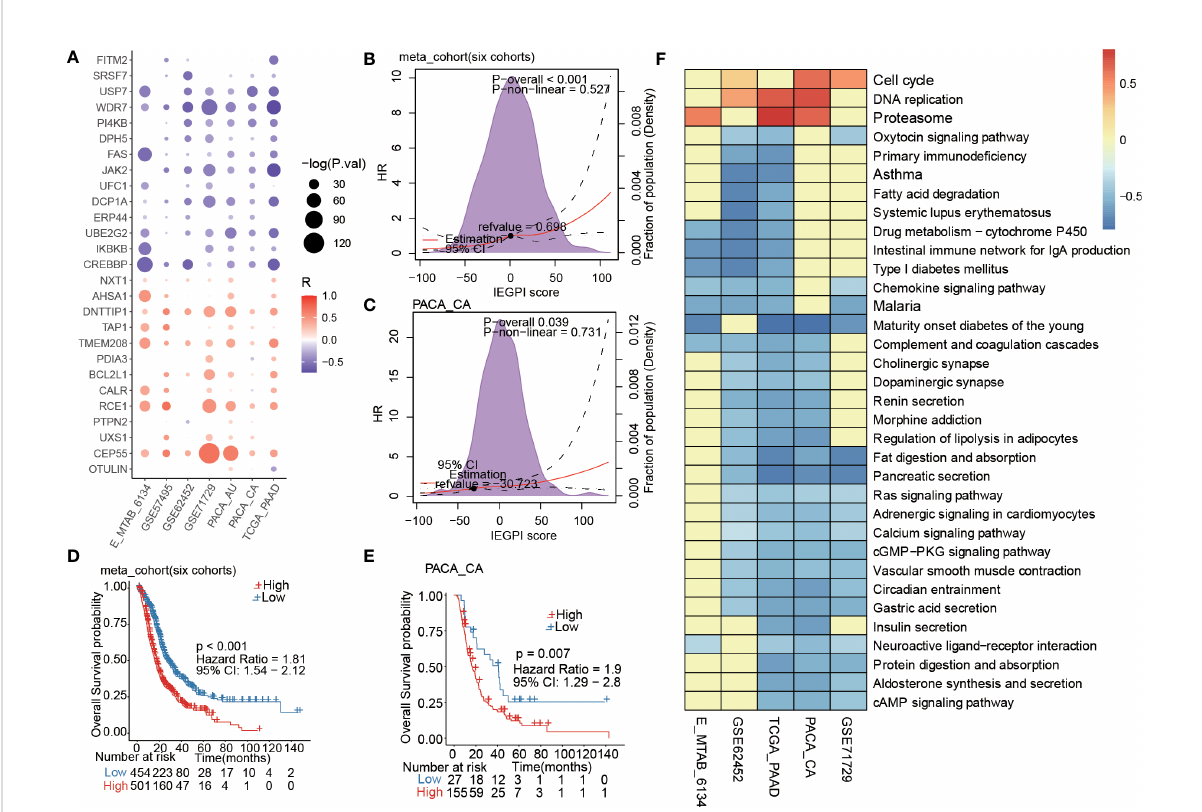
FIGURE 2 Prognostic estimation of IEGPI score. (A) Association of the IEGPI score with the 27 prognostic immune escape genes; (B, C) the HR value distribution with different IEGPI score in the training and validation cohorts; (D, E) Kaplan-Meier curves of IEGPI score in the training cohort and validation cohorts; (F) Relationship between the IEGPI score and cell signaling pathways via KEGG